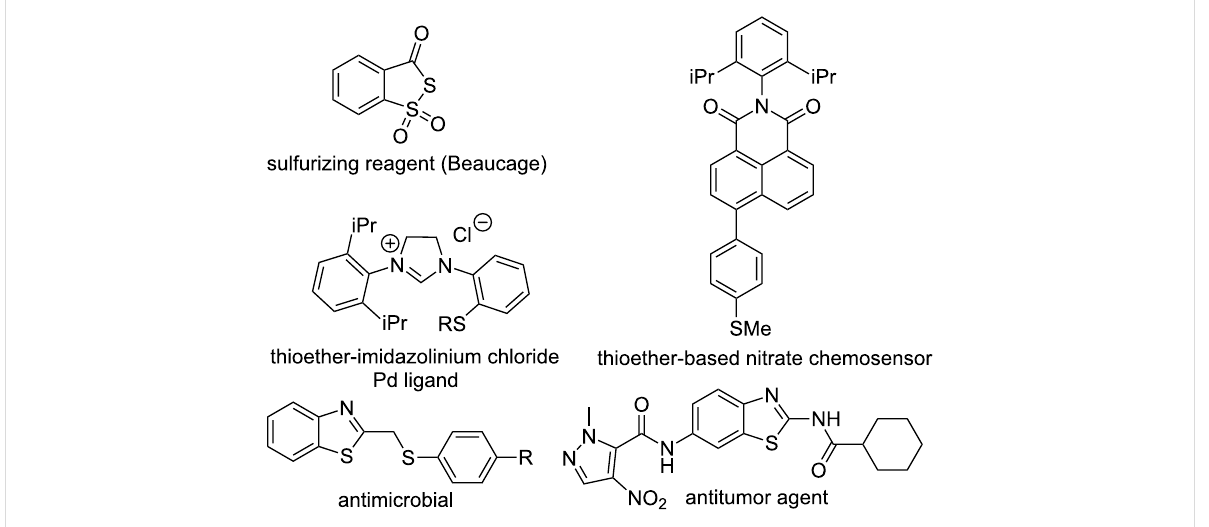
Figure 1: Examples of some pharmaceutically and chemically important